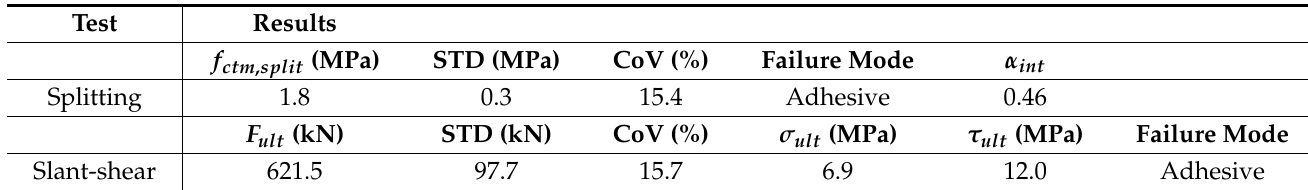
Table 6. The main laboratory tests’ outcomes for the interface in reference [25]. n/a—not applicable, n/t—not tested.